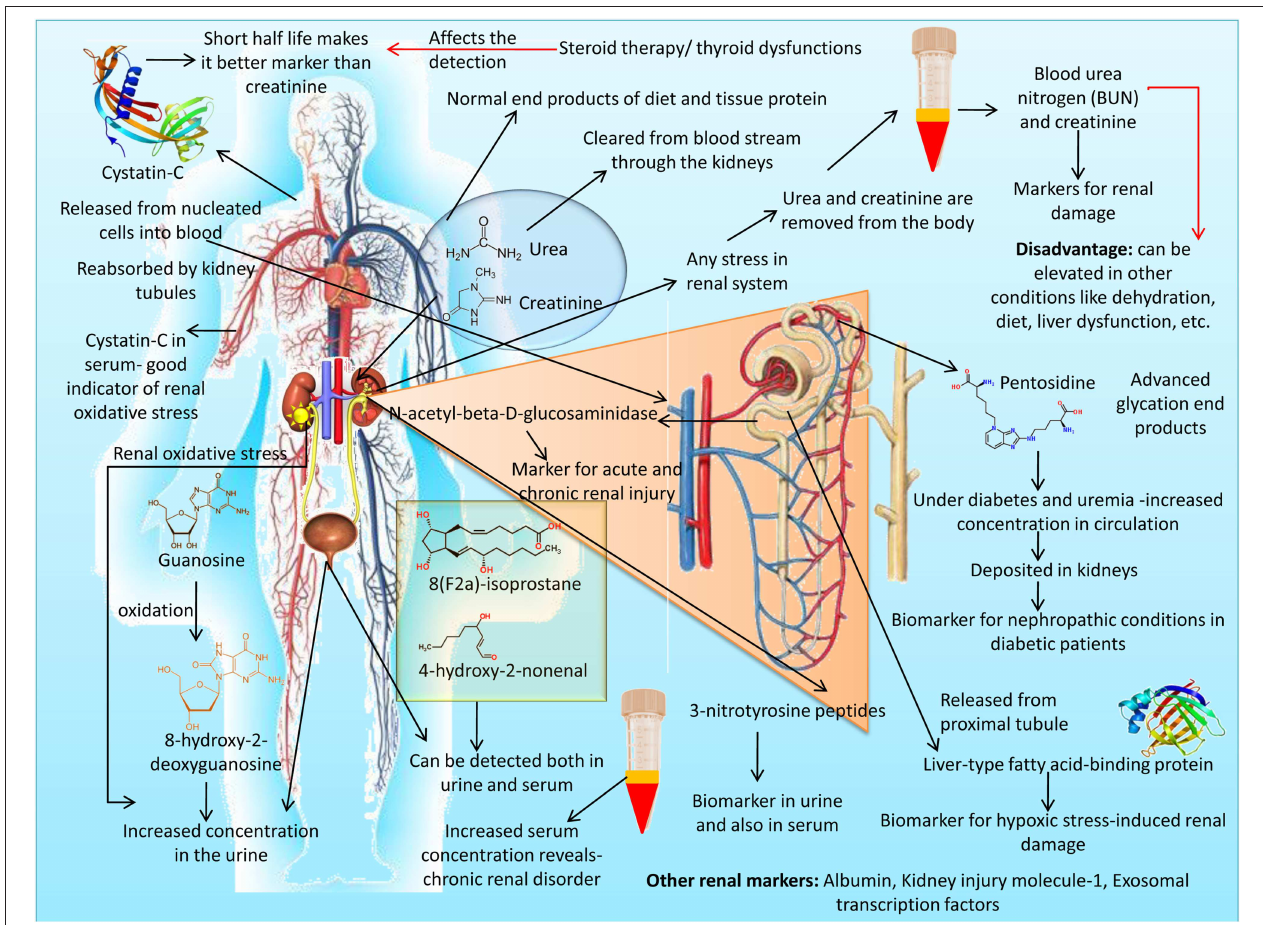
FIGURE 6 | An overview on renal stress biomarkers: various biomarkers, such as urea, creatinine, 8-hydroxy-2-deoxyguanosine, cystatin-C, and others are used to assess the status of renal system.